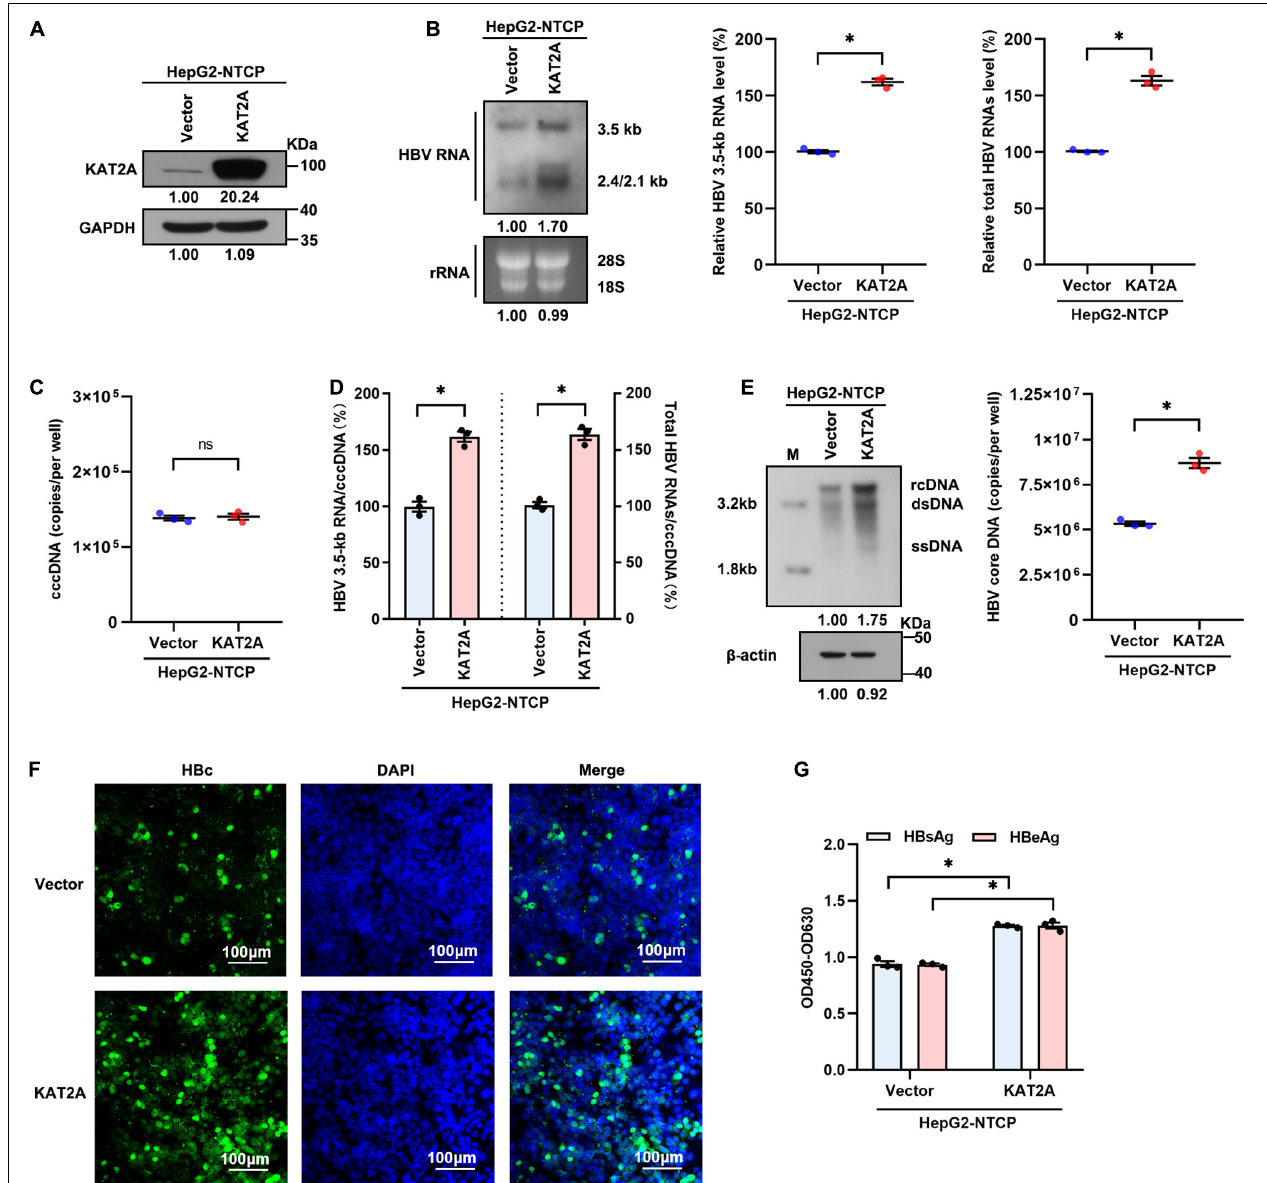
FIGURE 3 | KAT2A overexpression promotes HBV transcription in the HBV infection cell model. HepG2-NTCP cells were infected HBV particles at 1-day post lentivirus expressing KAT2A plasmids transduction. At 4 days after infection. (A) The expression of KAT2A was detected by western blot. (B) The effect of KAT2A overexpression on HBV RNAs was analysed by Northern blotting and real-time PCR. (C) Taq-man probe qPCR was used to detect the HBV cccDNA level. (D) The level of HBV 3.5-kb RNA, total HBV RNAs, and cccDNA were used to calculate the ratio of HBV 3.5-kb RNA to cccDNA and total HBV RNAs to cccDNA. (E) HBV core DNA was quantified by Southern blotting and absolute quantification PCR. The level of β -actin was used as a loading control for HBV core DNA. (F) HBc was produced by HBV-infected HepG2-NTCP cells. Intracellular HBc was visualised by immunofluorescence staining. The scale bar is 100 µ m. (G) Cell culture supernatant was collected for HBsAg and HBeAg analysis via ELISA. * P < 0.05.